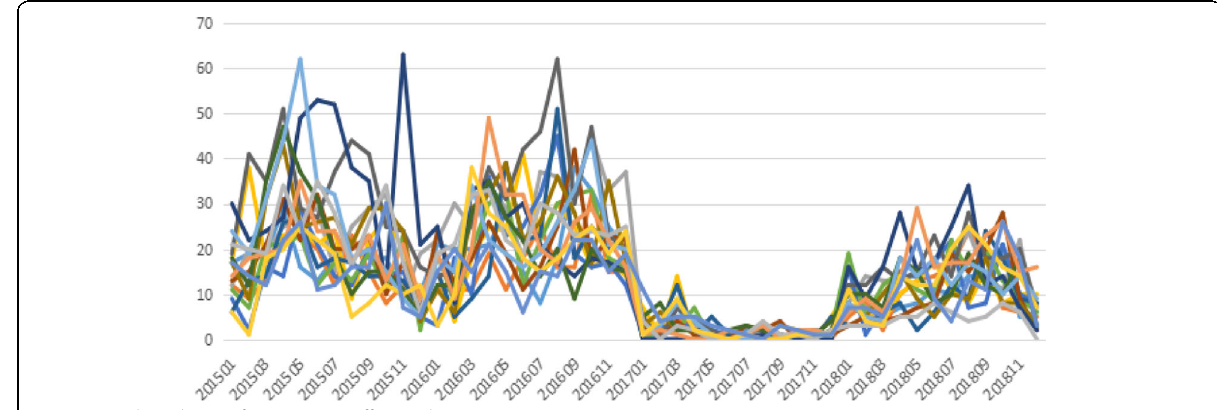
Fig. 7 Spatial incidence of category 5 traffic